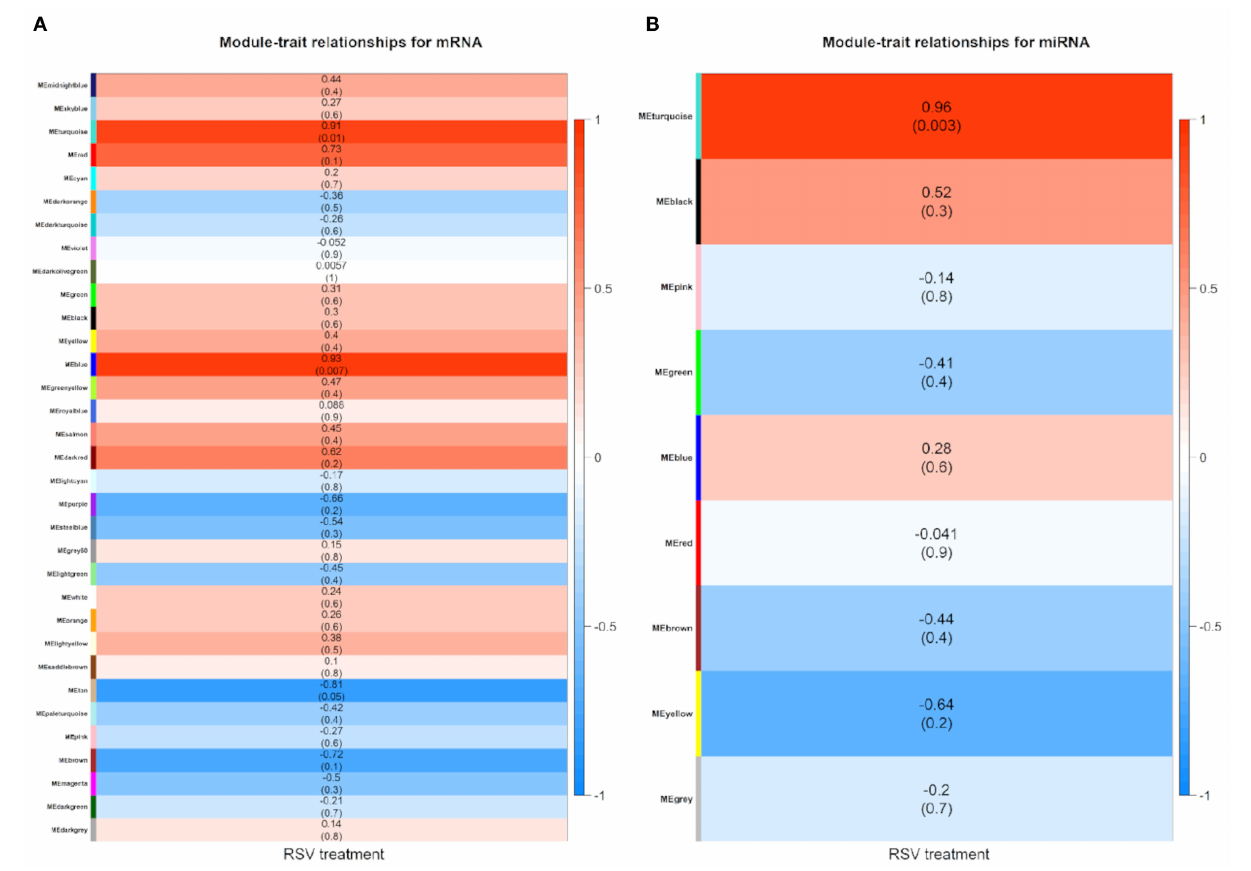
FIGURE 5 | Module–trait relationship heatmap between RSV treatment and control groups for (A) mRNAs and (B) miRNAs, respectively. Each row indicates module eigengenes with the correlation coefficients ( P -values in the brackets), where the red color represents positive correlation and the blue color represents negative